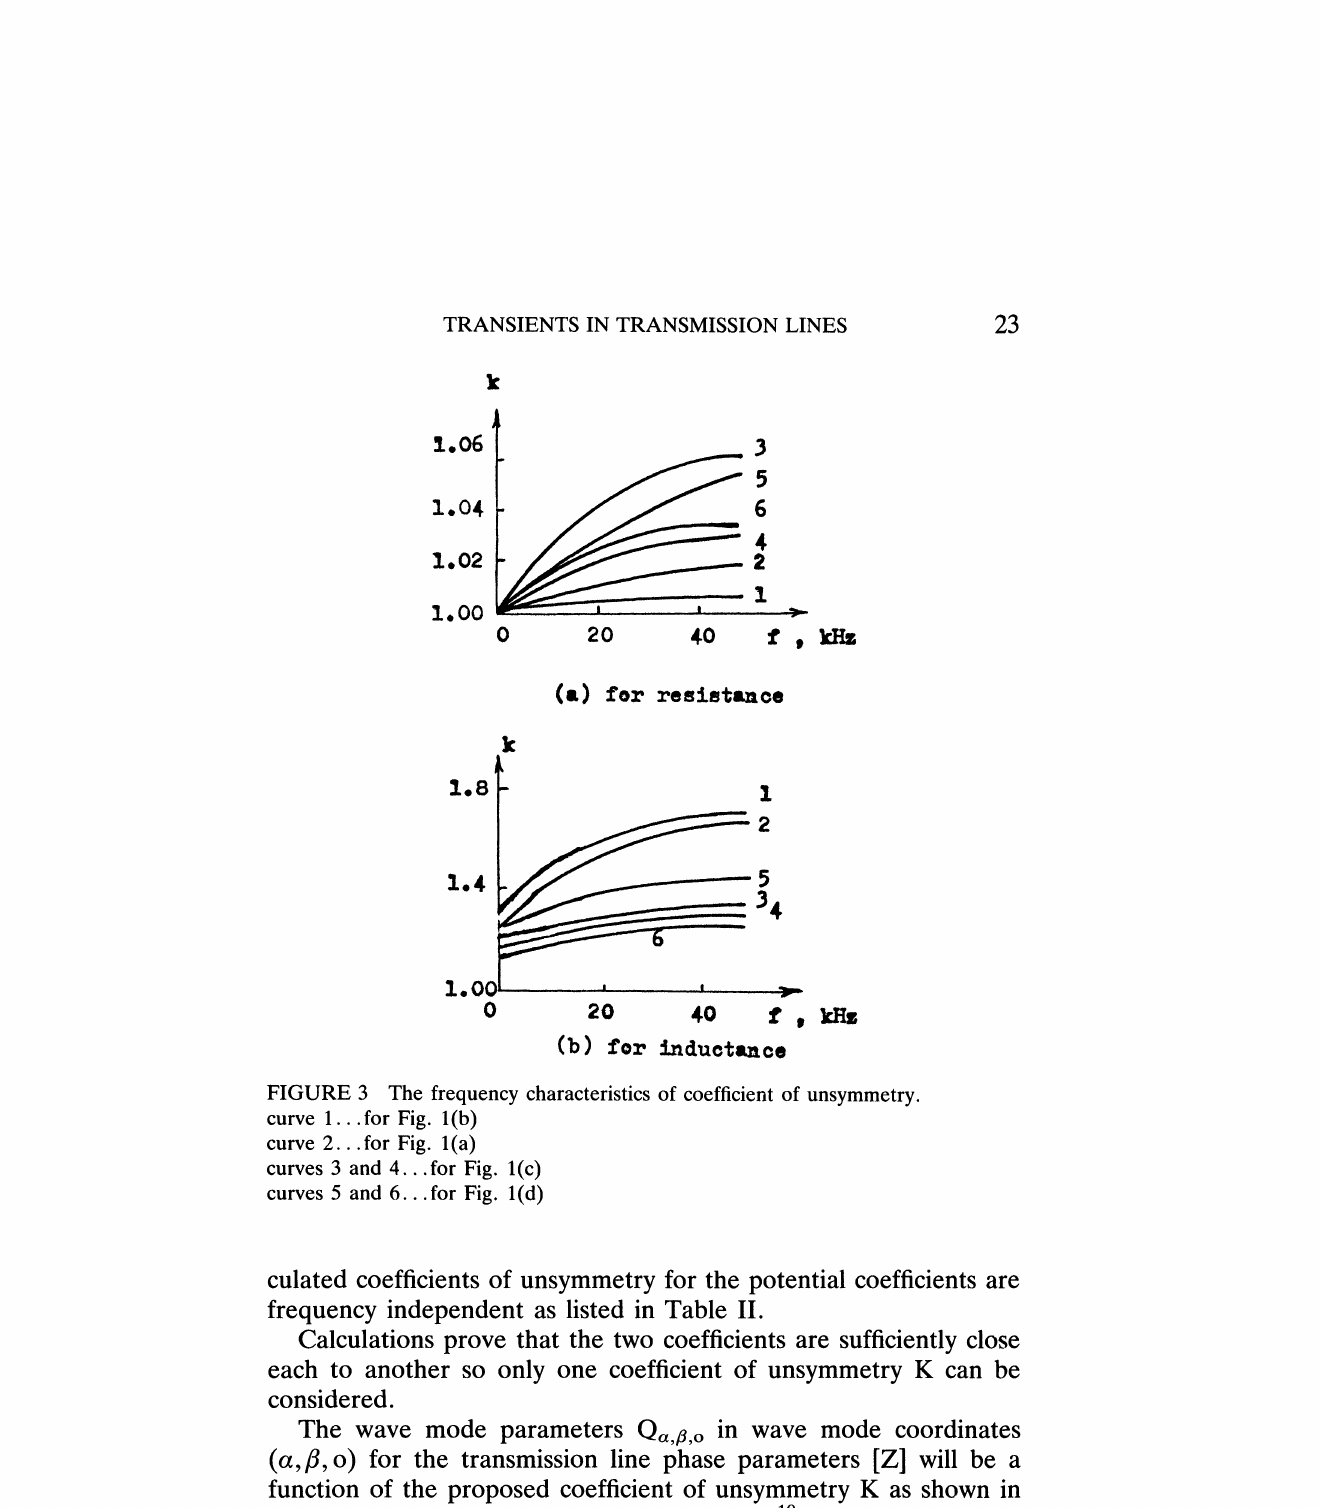
FIGURE 3 The frequency characteristics of coefficient of unsymmetry. curve 1...for Fig. l(b) curve 2... for Fig. l(a) curves 3 and 4...for Fig. l(c) curves 5 and 6...for Fig.